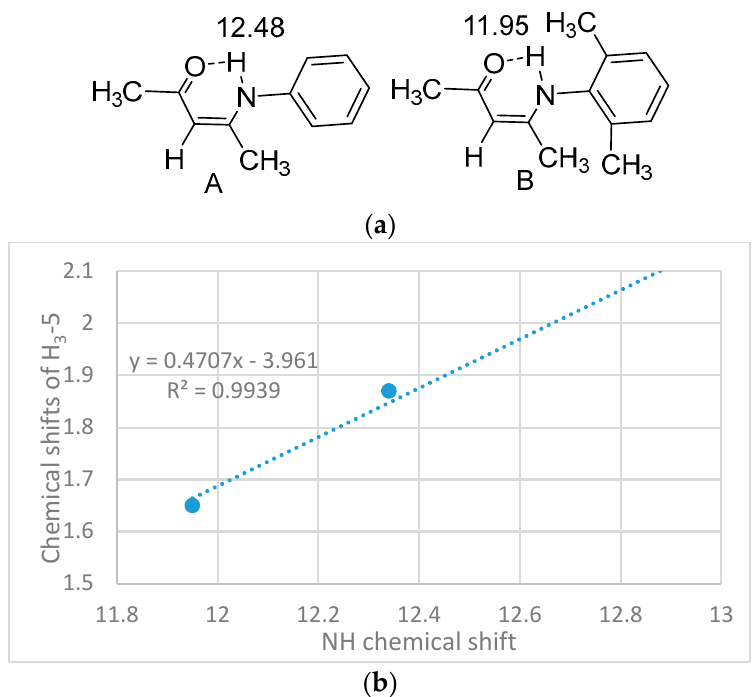
y = 0.4707x ‐ 3.961 Figure 4. ( a ). Demonstration of possible ring current effects. In A the ring is twisted 34° out to the double bond plane, whereas in B the twist angle is 89°. Data from [12]. ( b ) Plot of 1 H chemical shifts of CH 3 ‐ 5 vs. NH chemical shifts for enaminones with following substituent at nitrogen phenyl substituent, o ‐ methyl, O , O ‐ dimethyl and 4 ‐ isopropyl. Data from [13–15].